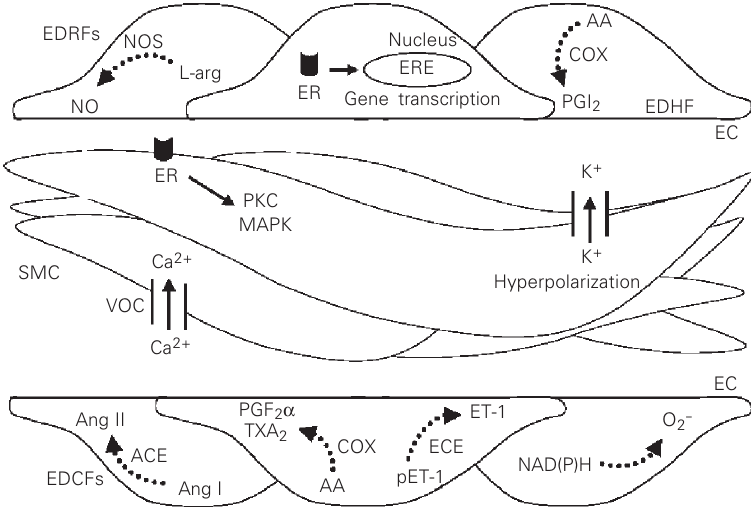
Figure 1. Putative mechanisms for the action of estrogen on the vascular system. By acting on endothelial cells, estrogen increases EDRFs (NO, EDHF and PGI 2 ) production/release and decreases release/actions of EDCFs (PGF 2 α , TXA 2 , Ang II, ET-1, O 2- ). By acting on vascular smooth muscle cells, estrogen activates K + channels, leading to cell hyperpolariza- tion, and blocks activation of Ca 2+ channels, decreasing intracellular Ca 2+ concentration. Actions of estrogen may be mediated by both direct genomic effects (activation of nuclear receptors and transcriptional events) and non-genomic effects (activation of rapid intracellu- lar signaling pathways). AA = arachidonic acid; ACE = angiotensin-converting enzyme; Ang I = angiotensin I; Ang II = angiotensin II; Ca 2+ channels = calcium channels; COX = cyclooxygenase; EC = endothelial cells; ECE = endothelin converting enzyme; EDCF = endothelium-derived contracting factor; EDHF = endothelium-derived hyperpolarizing fac- tor; EDRF = endothelium-derived relaxing factor; ER = estrogen receptor; ERE = estrogen- response element; ET-1 = endothelin-1; K + channels = potassium channels; L-arg = L- arginine; MAPK = mitogen-activated protein kinase; NO = nitric oxide; NOS = nitric oxide synthase; O 2- = superoxide anion; pET-1 = prepro-endothelin-1; PGF 2 α = prostaglandin F 2 alpha; PGI 2 = prostacyclin; PKC = protein kinase C; SMC = smooth muscle cells; TXA 2 = thromboxane